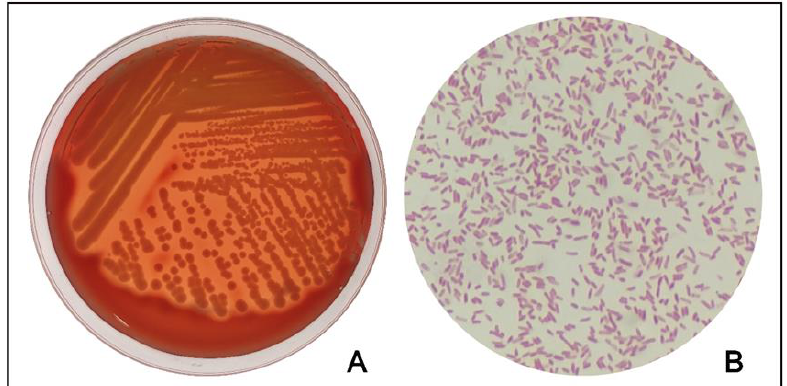
Figure 3. This bacterium is rod-shaped and Gram-negative and shows β -hemolytic activity on ovine blood agar plates. ( A ) This bacterium was incubated on the ovine blood agar plates overnight at 37 ◦ C; ( B ) gram staining showed the bacterium is rod-shaped and Gram-negative. The 16S rRNA gene of the isolated strain was amplified by the universal primers, 27F:5 ′ -AGAGTTTGATCCTGGCTCAG- 3′ and 1492R: 5′ -GGTTACCTTGTTACGACTT- 3′. The PCR conditions consisted of 94 ◦ C for 5 min, followed by 35 cycles of 94 ◦ C for 30 s, 55 ◦ C for 45 s, 72 ◦ C for 90 s, and a final extension at 72 ◦ C for 6 min. The obtained sequences were sequenced at Beijing Tsingke Biotechnology Co., Ltd, Xi’an, China. A BLAST